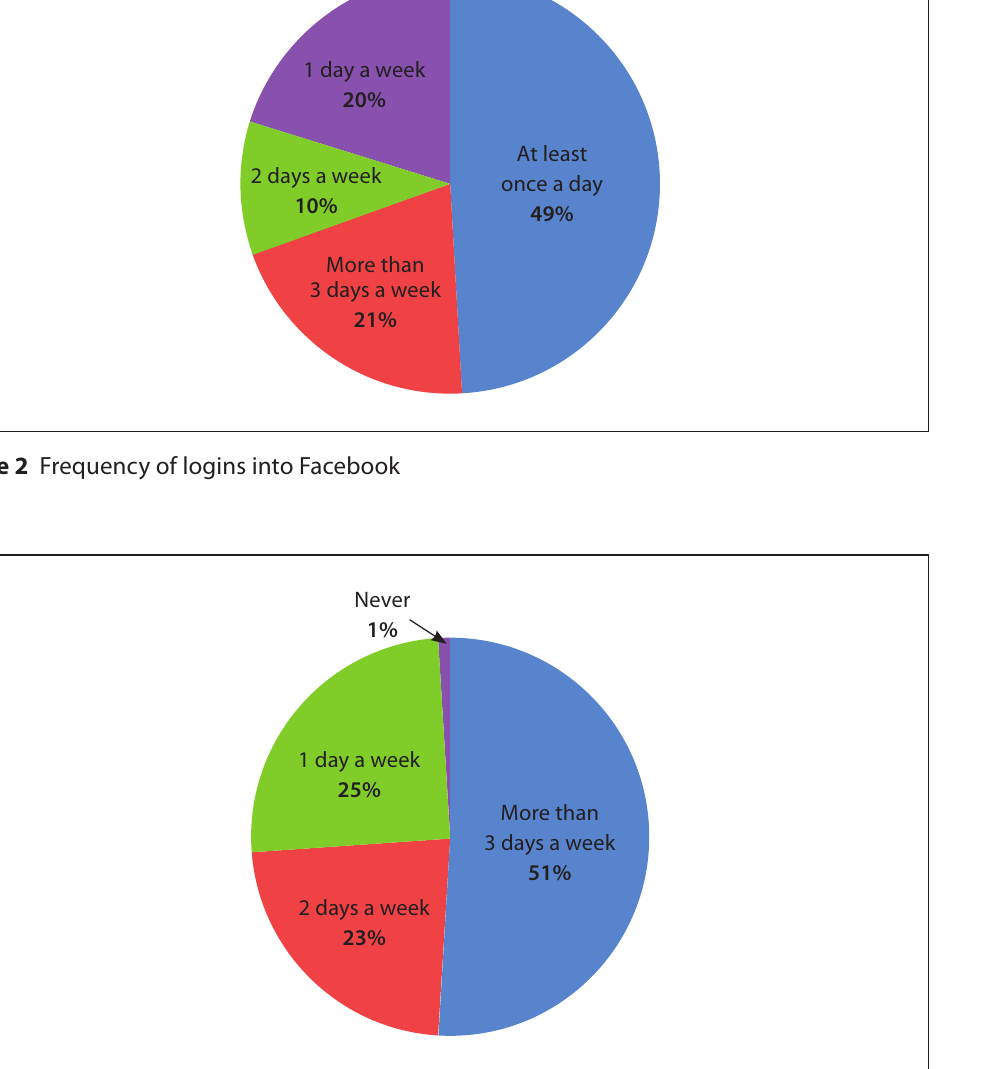
Figure 3 Frequency of logins into WawasanLearn by Facebook